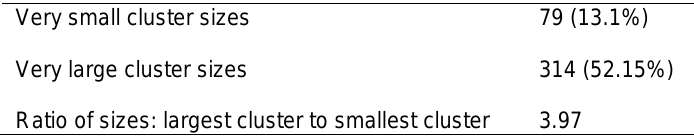
Figure 1. Cluster sizes obtained by a biestatic cluster